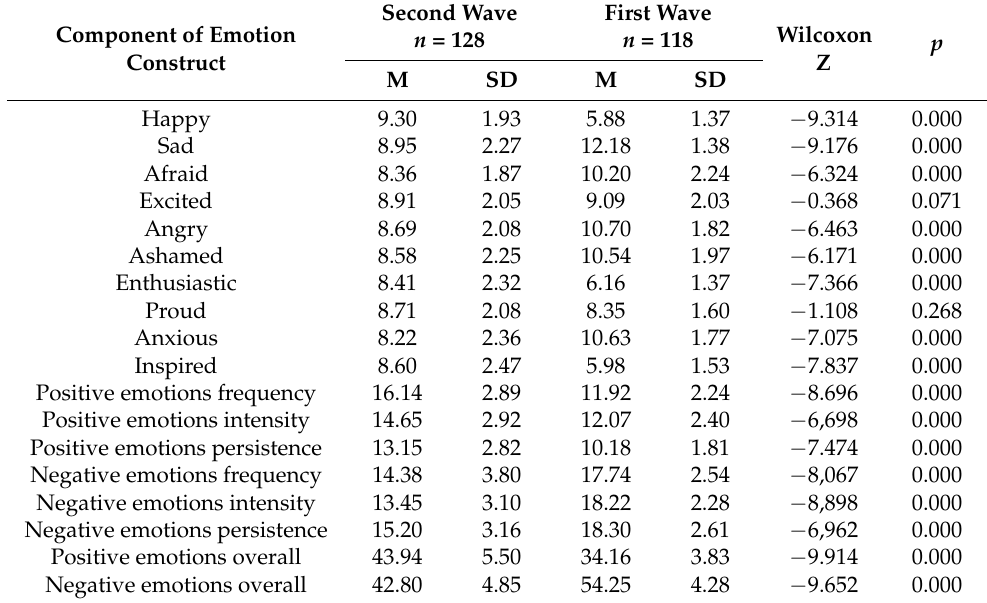
Table 1. Estimations of components of emotion after the first and second waves.